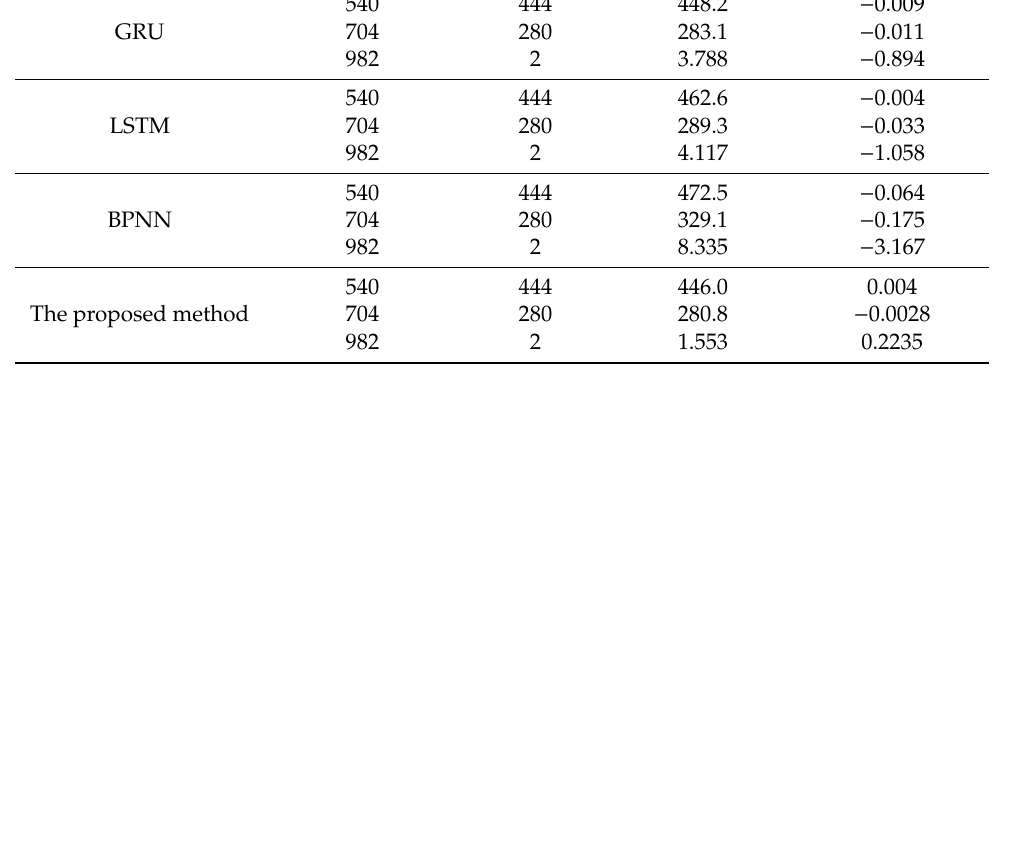
Figure 12. RUL prediction results of different methods.